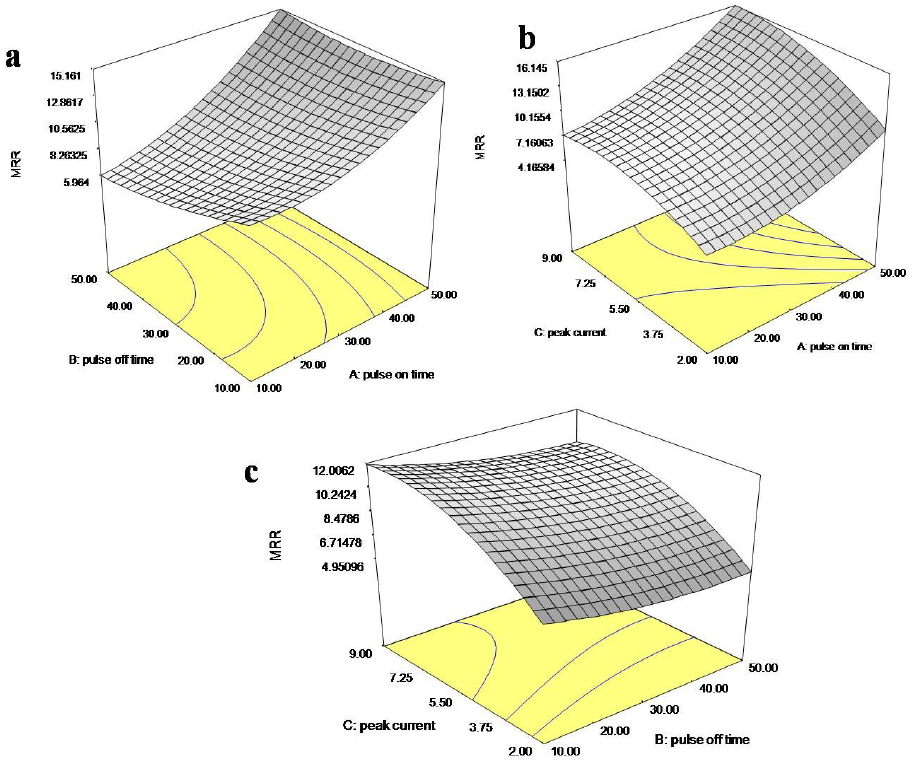
Figure 4: Interaction Plots for MRR (a) Ton Vs Toff; (b) Ton Vs Ip; (c) Toff Vs